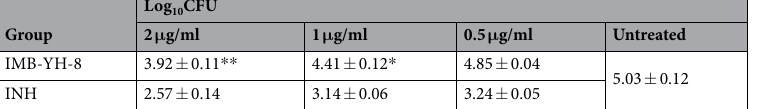
Table 5. Activity of IMB-YH-8 against intracellular M . tuberculosis H37Rv. Values represent mean ±